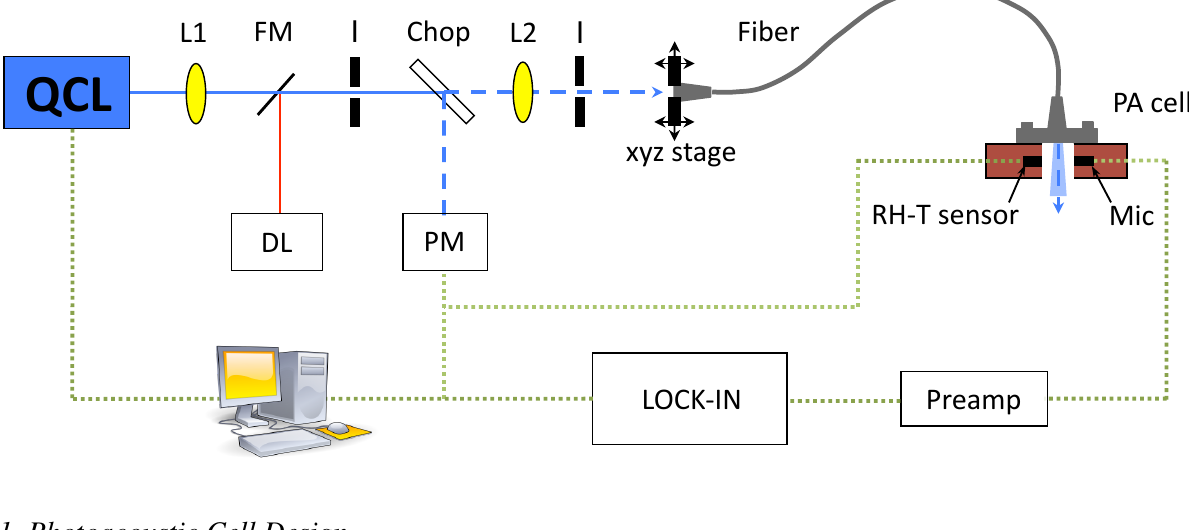
Figure 2. Setup for photoacoustic measurements: QCL = quantum cascade laser, FM = flipping mirror, L = lens, I = Iris, DL = diode laser (for alignment tasks), Chop = chopper, PM = power meter, Mic= microphone and RH-T = relative humidity-temperature